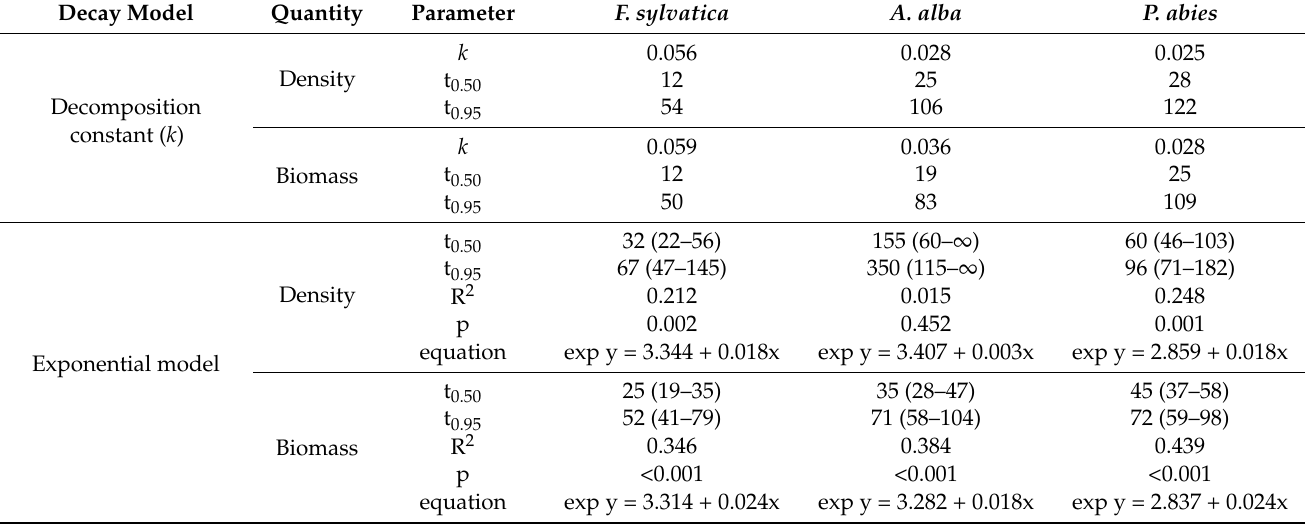
Table 4. Estimated decomposition rates and half-lives (years) and their 95% confidence intervals in parentheses, decomposi- tion rate constants k (year − 1 ) and values of models